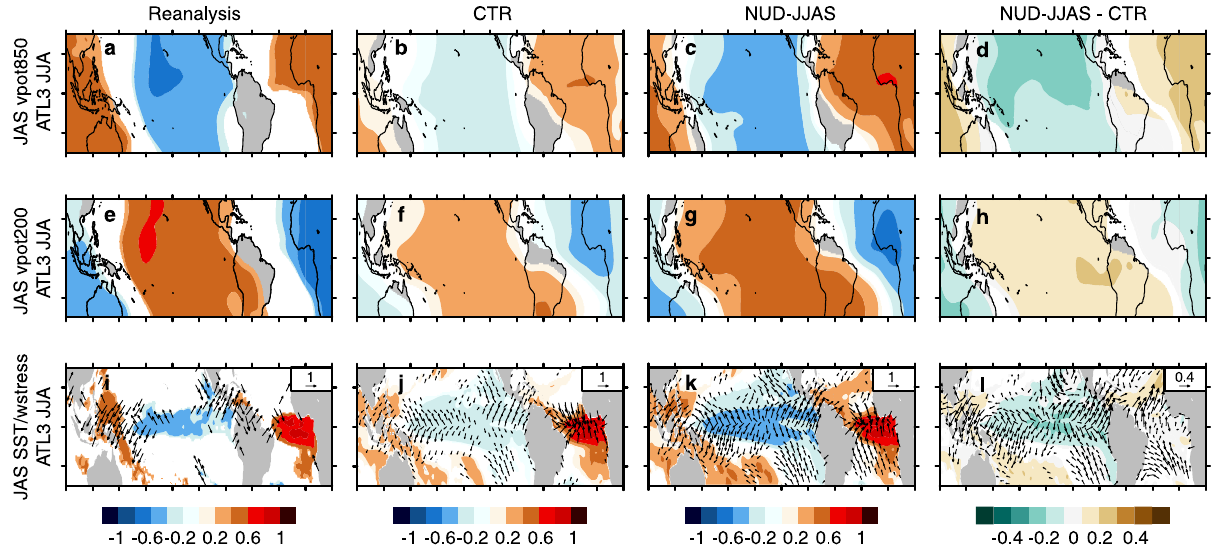
Fig. 4 Dynamical description of the ATL3 teleconnection established in JAS. a – c Correlation pattern between JJA ATL3 index and the JAS velocity potential at 850 hPa for ERA-interim (1st column), CTR (2nd column), and NUD-JJAS (3rd column). Only signi fi cant values at a 95% con fi dence level are shown. d Differences between the correlations in panels c and b . Only signi fi cant differences at the 95% con fi dence level are shown. e – h The same as in panels a – d but against the velocity potential at 200 hPa. i – l As in panels a – d but for the SSTs (in shaded colors) and the surface winds (in vectors). The period is 1981 –